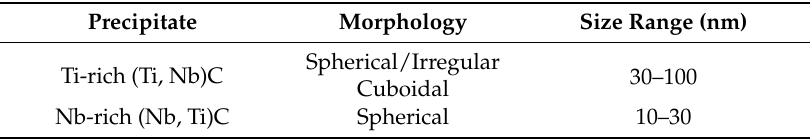
Table 3. Classification of different precipitates in the test microalloyed steel.